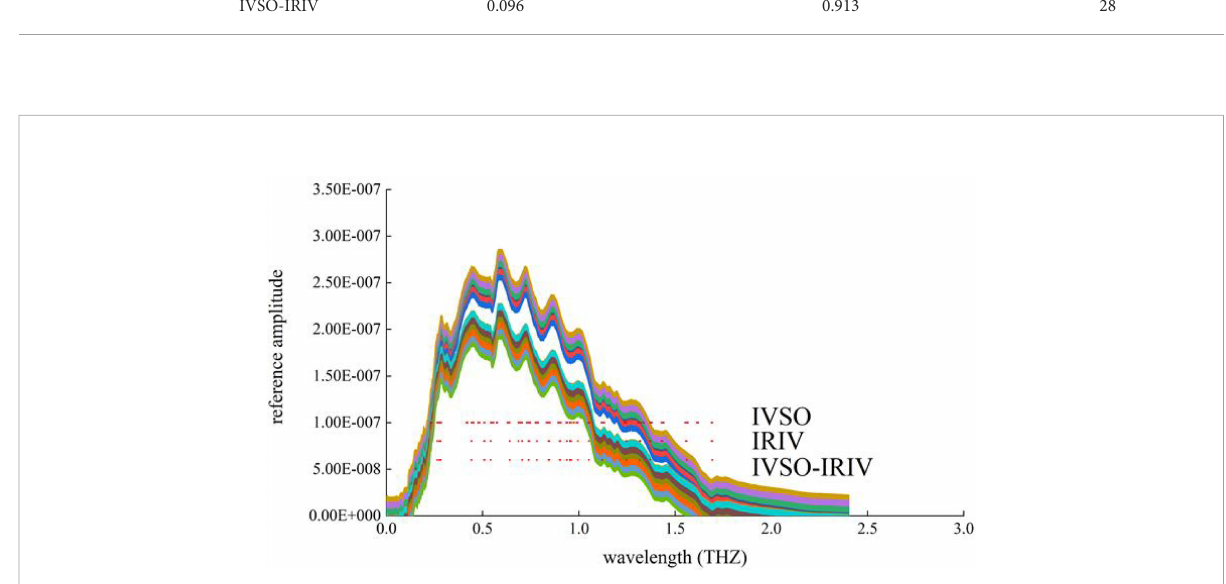
FIGURE 6 Terahertz characteristic wavelength distribution.